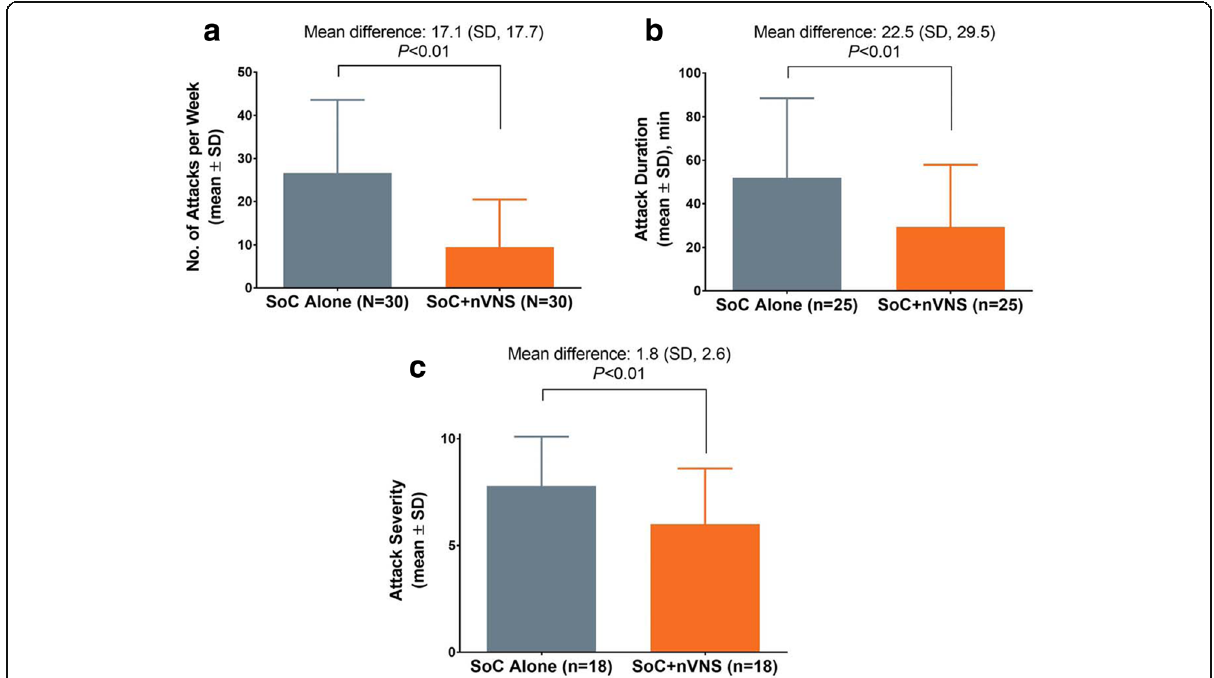
Fig. 1 CH attack frequency ( a ), duration ( b ), and severity ( c ) with SoC alone and with SoC + nVNS. P values are from paired t tests. Patients who had 0 attacks while using nVNS therapy were excluded from analysis of attack duration and severity. Attack severity was rated on a 0 to 10 scale, with higher scores indicating greater severity. Abbreviations: CH, cluster headache; nVNS, non-invasive vagus nerve stimulation; SD,